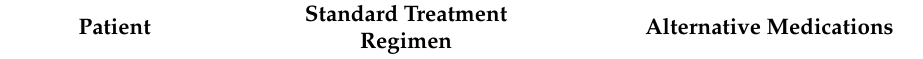
Table 8. Antibacterial therapy for pregnant women and children. Adapted from personal communi- cation of Dr. Aitkuluev N. (principal adviser, the Republican Clinical Infectious Diseases Hospital; on 2 March 2022) and www.who.int/news-room/fact-sheets/detail/brucellosis, accessed on 12 February 2022